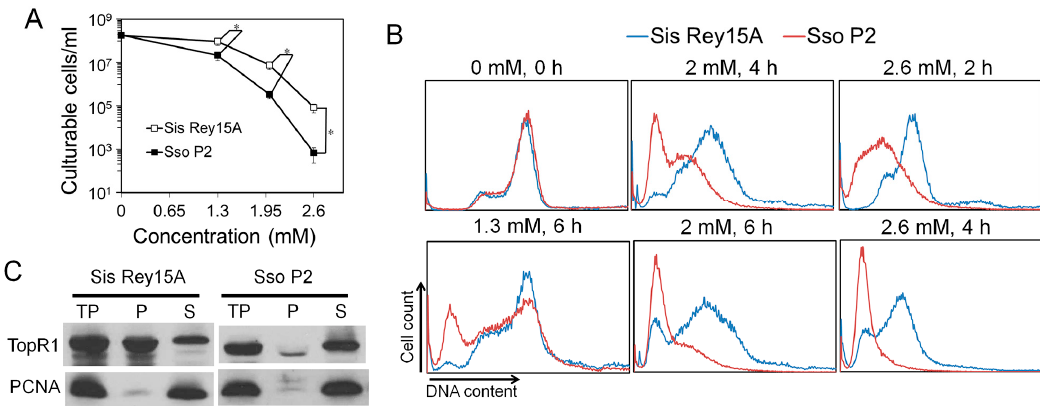
Figure 6. TopR1 was bound to the chromatin part in S. islandicus . ( A ) S. islandicus Rey15A and S. solfataricus P2 cultures were treated with 0, 1.3, 2, or 2.6 mM MMS, and cell viability was analyzed after 2 h of treatment; ( B ) comparison of cellular DNA content of S. islandicus Rey15A (blue line) and S. solfataricus P2 (red line) during MMS treatment. Selected samples from Supplementary Figure S1 are shown, and the MMS concentration and treatment time are indicated; ( C ) western blots analysis of the subcellular location of TopR1 in S. islandicus Rey15A and S. solfataricus P2. TP, total protein; P, pellet (chromatin-rich fraction); S, supernatant (cytoplasm fraction). Antiserum against PCNA3 was used as a loading control. The asterisk represents p values less than 0.05. The p value was calculated by paired t test.